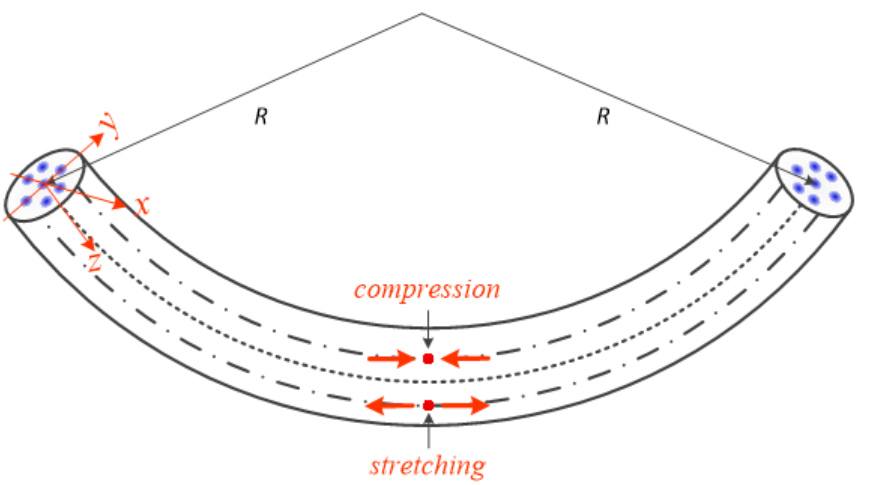
Figure 3. Schematic diagram of a bent MCF with a bending radius of R. The inner side cores will be compressed, while the outer side cores will be stretched. As a result, bending will generate different local tangential strains in distinct spatial cores. Adapted with permission from Ref. [31] © 2018 IEEE.